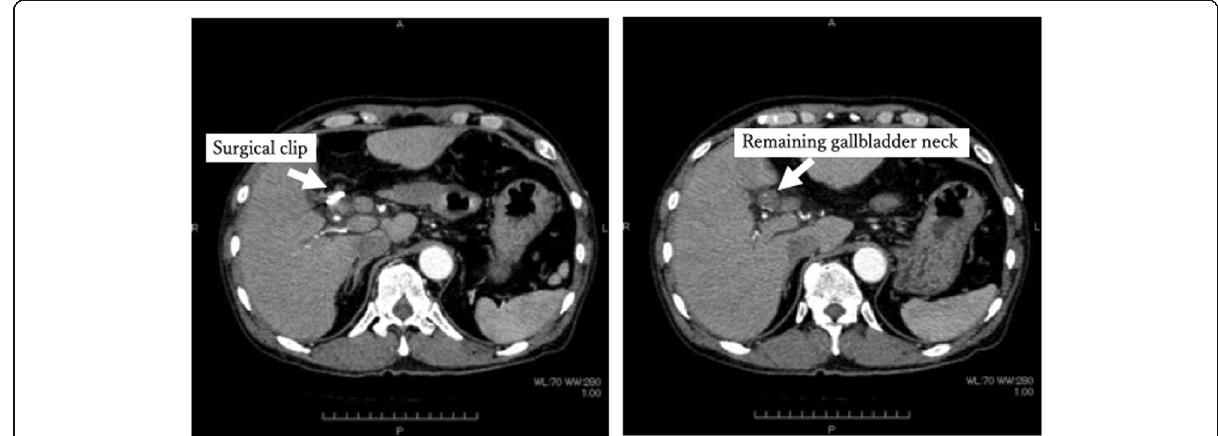
Fig. 3 Contrast CT after LC. Contrast CT showed no leakage of the contrast agent and pseudoaneurysm